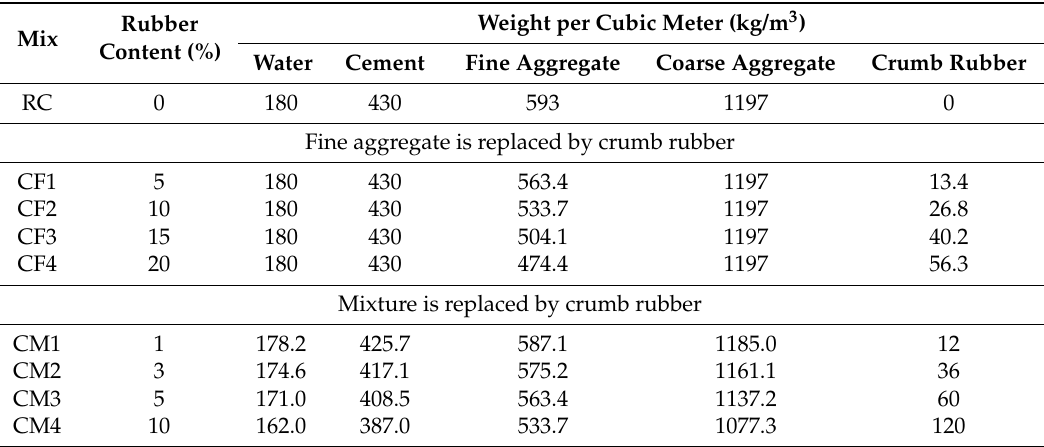
Table 1. Mixture proportions of crumb rubber concrete.